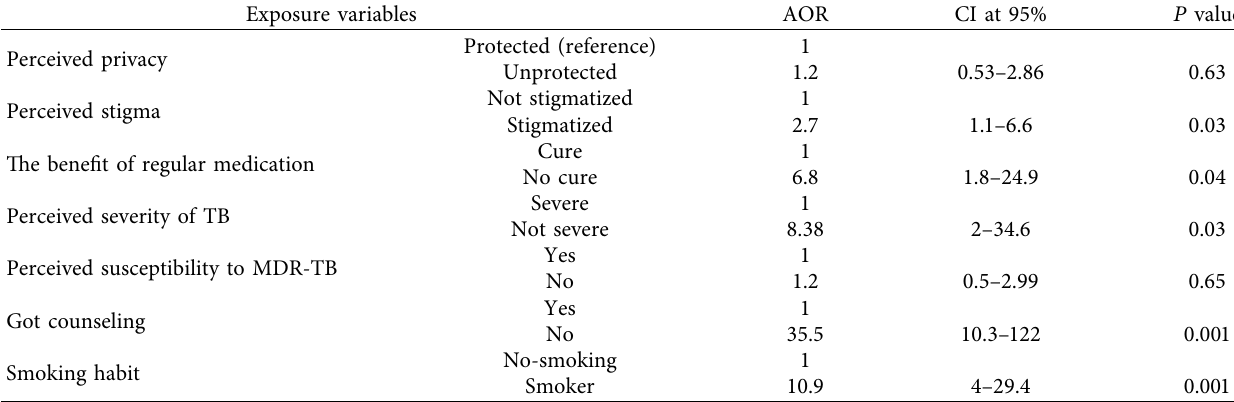
Table 6: Factors independently associated with nonadherence to anti-TB treatment among TB patients in Gambella region. Exposure variables